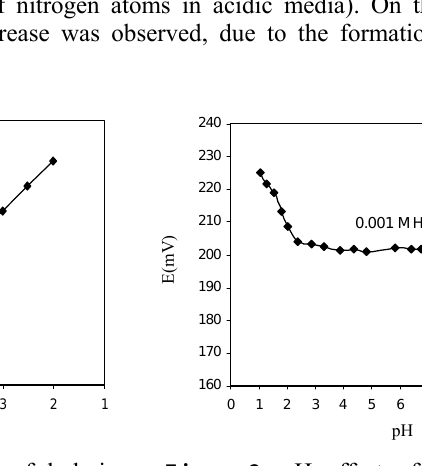
Figure 3. pH effect of the test solution (1.0 × 10 -3 M of Ho 3+ ) on the